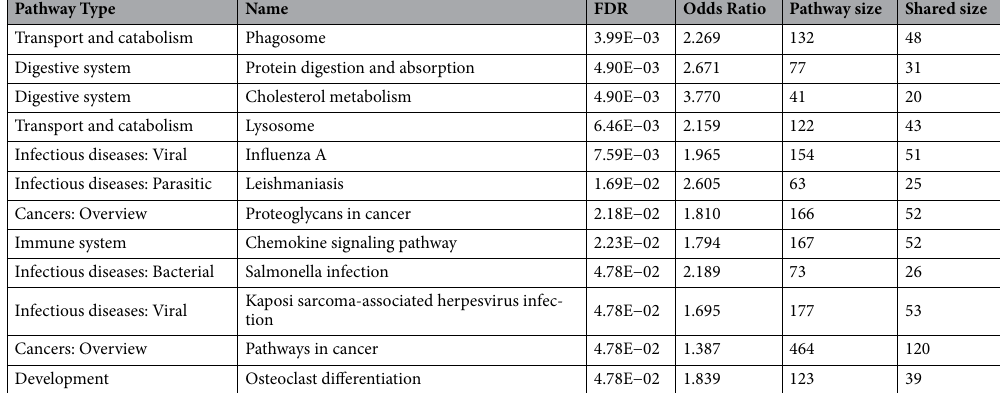
Table 2. Enriched pathways of genes that are significantly correlated with NCPT variables at FDR level 0.05. More than half of these pathways are related to immune